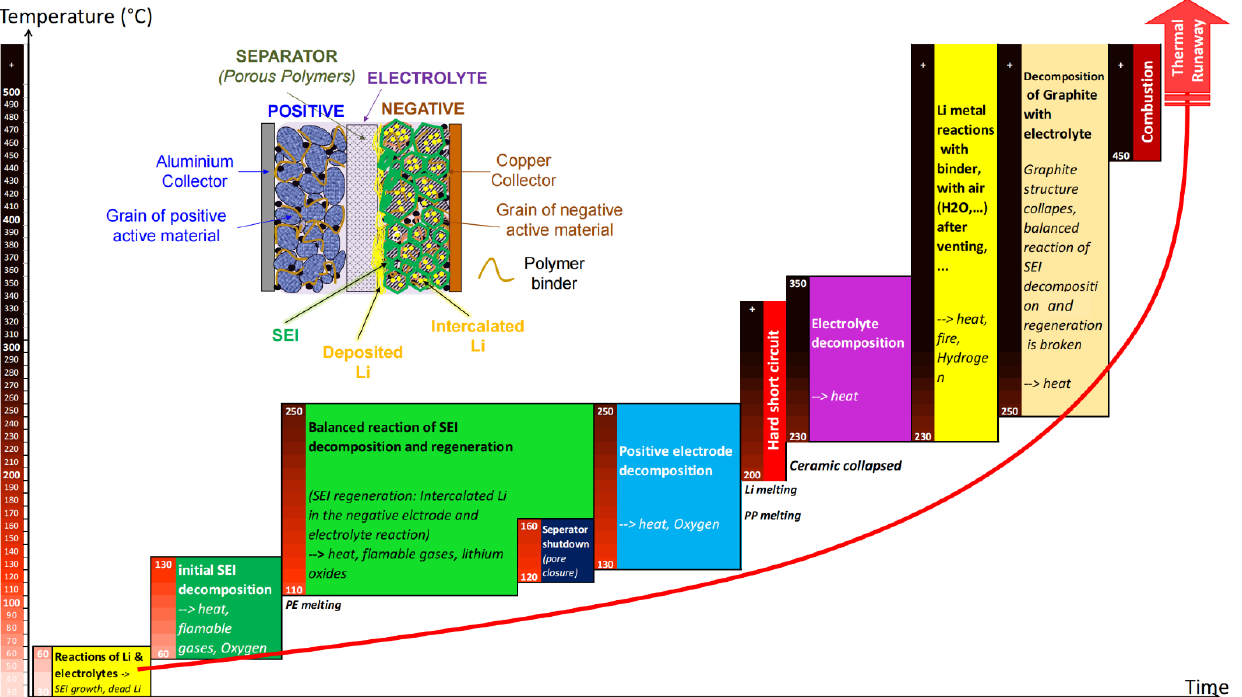
Figure 5. Exothermic reaction in different stages of LIB thermal runaway [39].